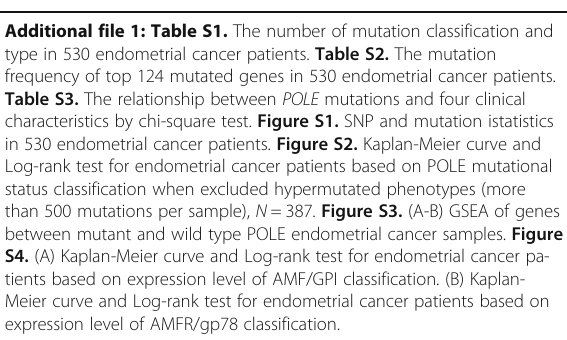
Additional file 1: Table S1. The number of mutation classification and type in 530 endometrial cancer patients. Table S2. The mutation frequency of top 124 mutated genes in 530 endometrial cancer patients. Table S3. The relationship between POLE mutations and four clinical characteristics by chi-square test. Figure S1. SNP and mutation istatistics in 530 endometrial cancer patients. Figure S2. Kaplan-Meier curve and Log-rank test for endometrial cancer patients based on POLE mutational status classification when excluded hypermutated phenotypes (more than 500 mutations per sample), N = 387. Figure S3. (A-B) GSEA of genes between mutant and wild type POLE endometrial cancer samples. Figure S4. (A) Kaplan-Meier curve and Log-rank test for endometrial cancer pa- tients based on expression level of AMF/GPI classification. (B) Kaplan- Meier curve and Log-rank test for endometrial cancer patients based on expression level of AMFR/gp78